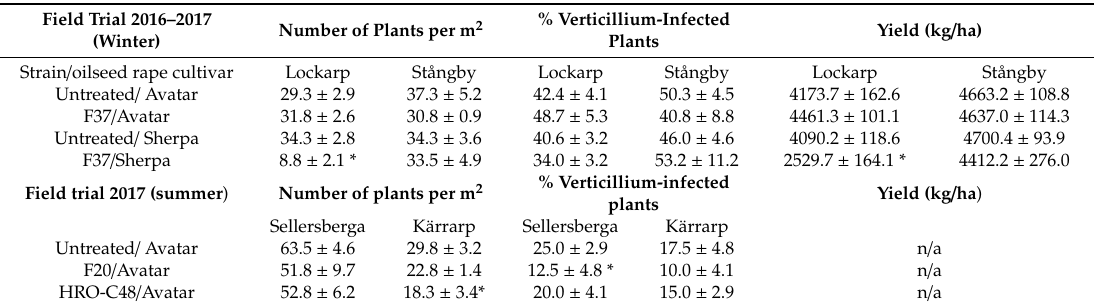
Table 2. E ff ect of the bacterial strains P. protegens F37, S. plymuthica F20 and HRO-C48 on the fitness and health of oilseed rape plants (Avatar cultivar) under field